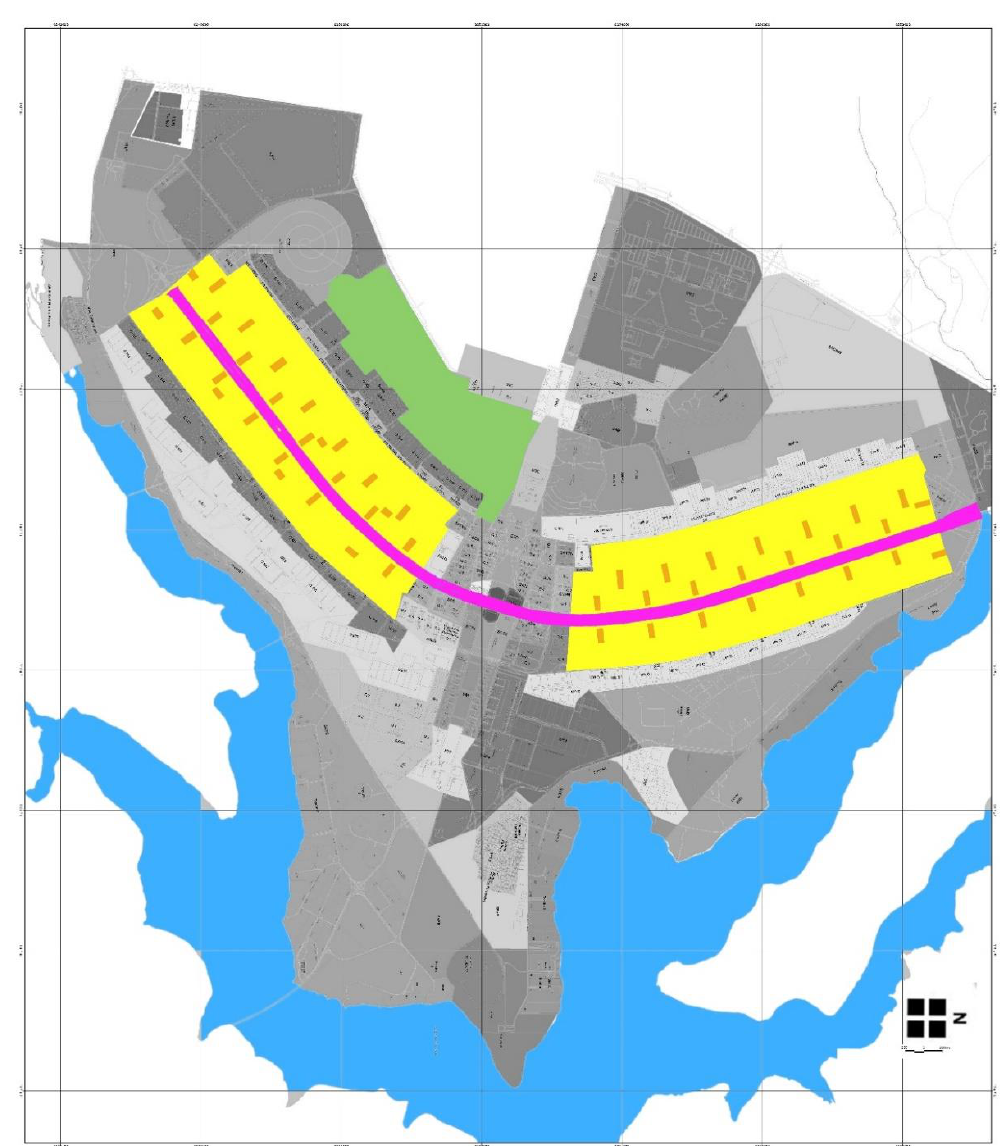
Figure 1: Plano Piloto and its five types of public spaces: Superquadras (yellow), Entrequadras (orange), ‘Eixão do Lazer’ (pink), Paranoa Lake (blue) and City Park (green). (Source of the base map: SEDUH/GDF,